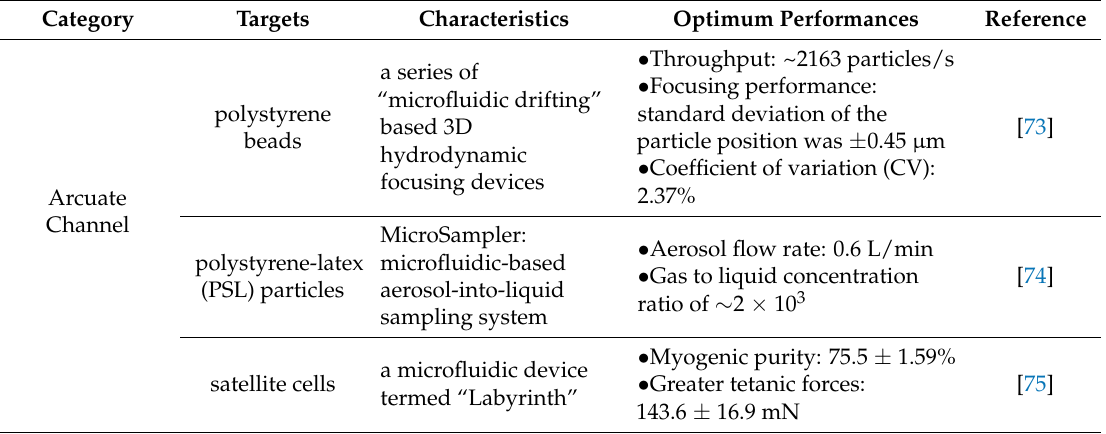
Table 3. The typical progress of curved-channel inertial